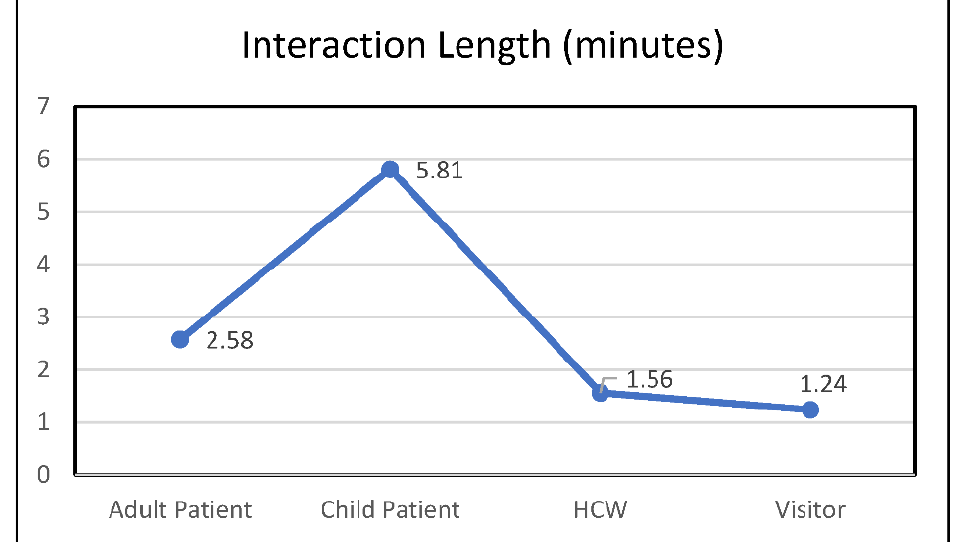
Figure 3. Interaction length by participant role.